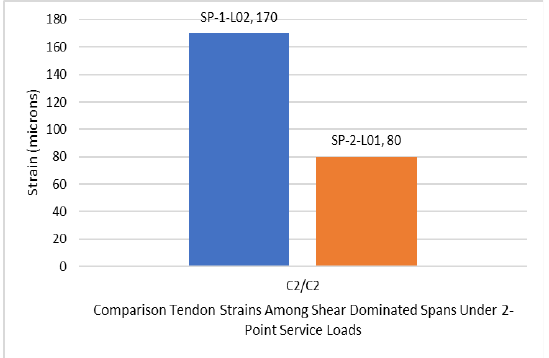
Figure 45. Comparison of maximum tendon strains recorded under two-point service loads between specimen SP-1 and SP-2.